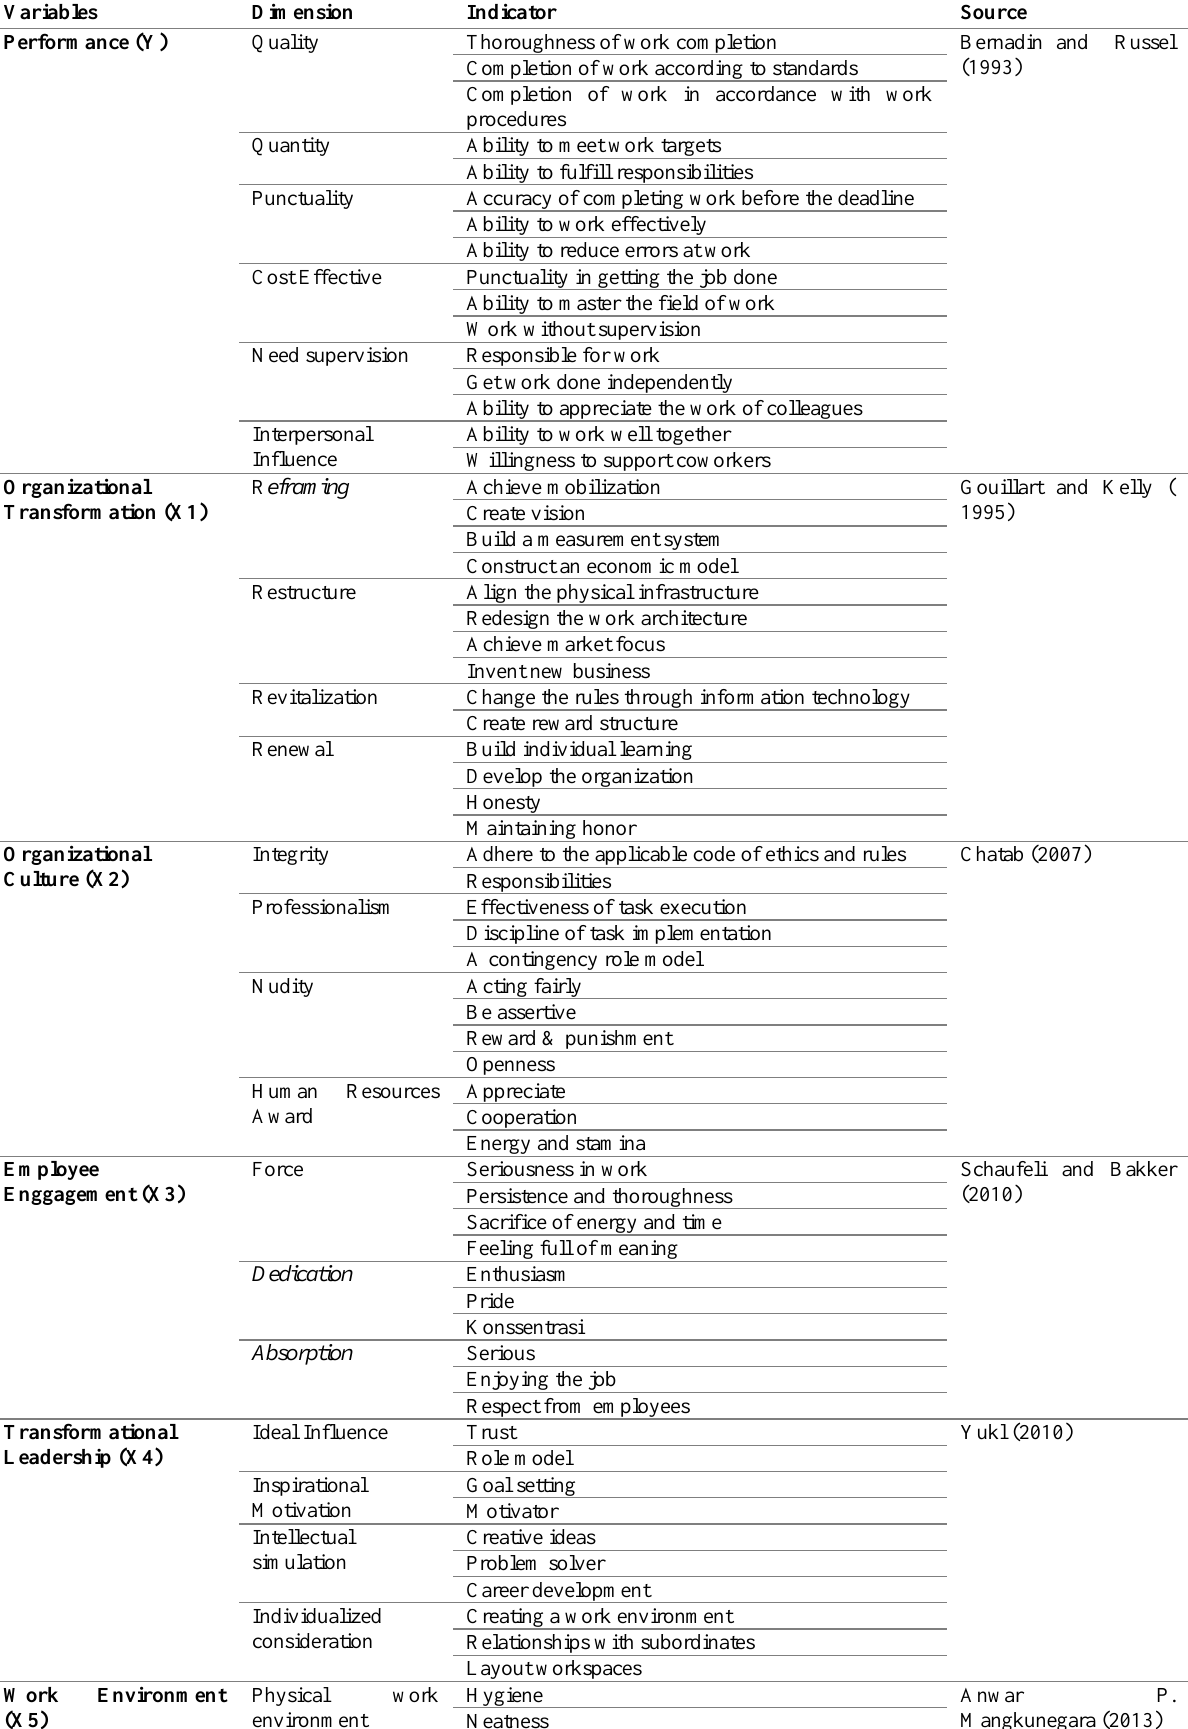
Table 1: Research